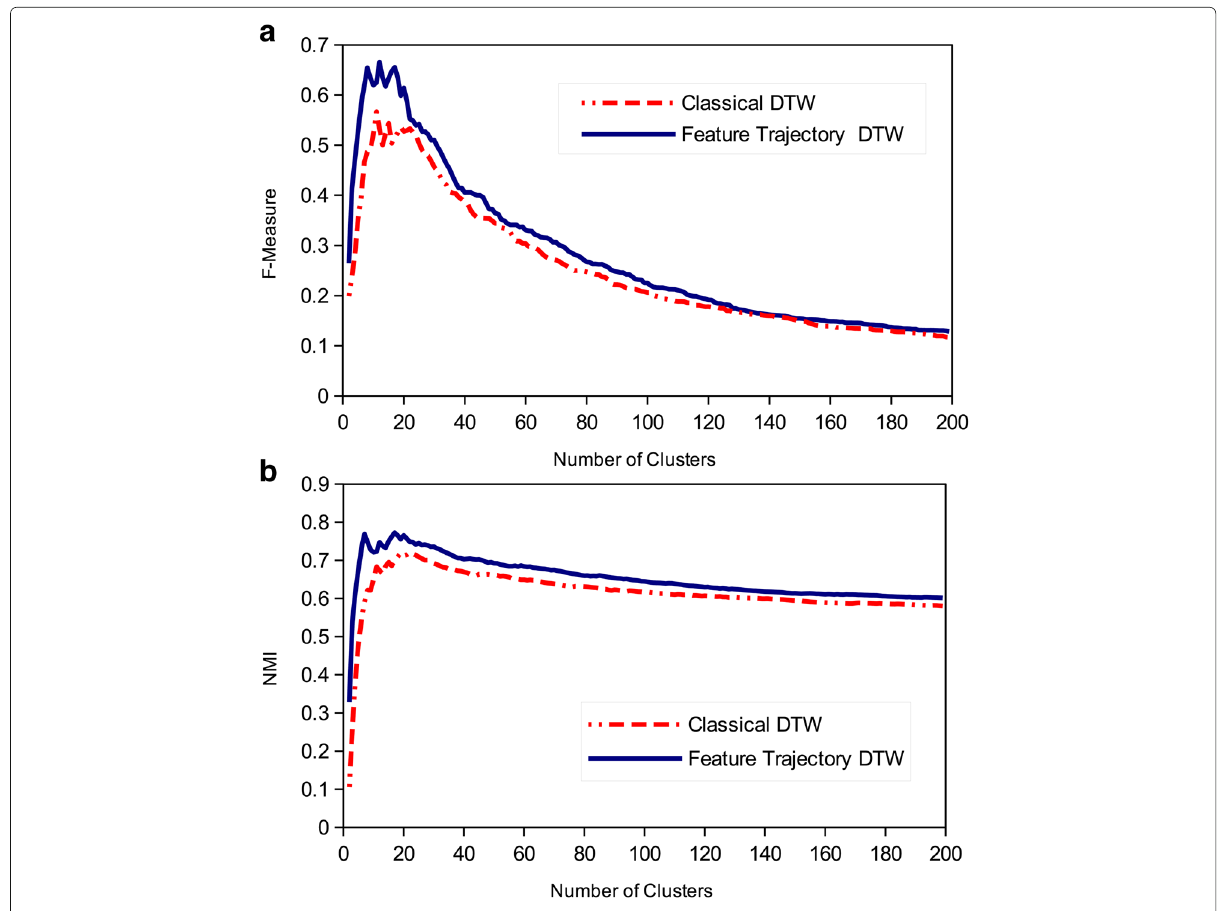
Fig. 5 Clustering performance for dataset 2 in terms of a F-measure and b